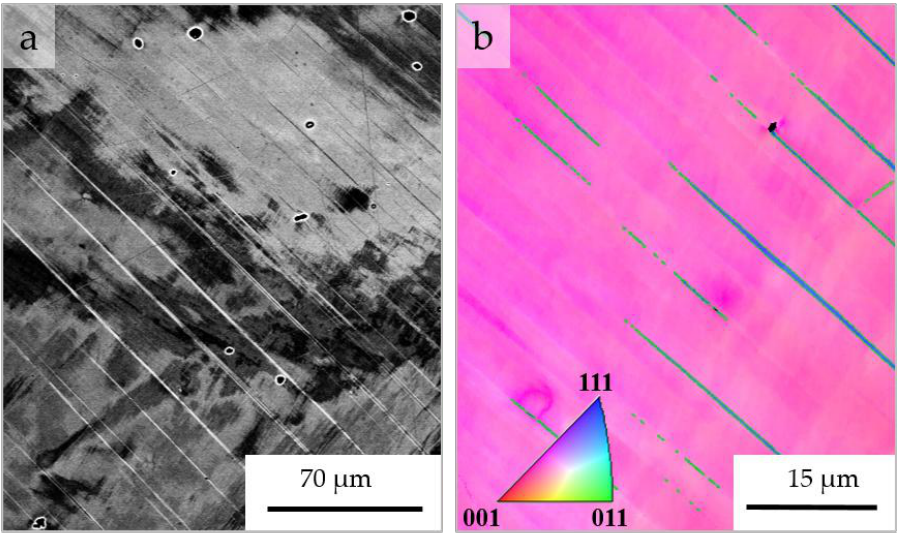
Figure 5. ( a ) ECCI and ( b ) EBSD examination of the deformation twins after tensile testing. In (b), ∑3 twin boundaries are highlighted in green. In the EBSD IPF map of (b), colors denote crystal directions normal to the polish plane.